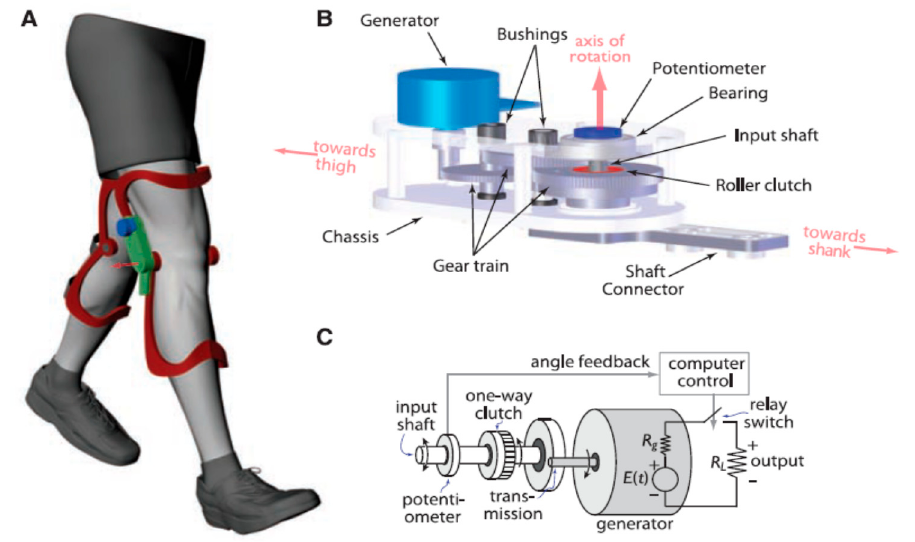
Figure 8. Knee wearable energy harvester with generative braking: ( A ) Conceptual drawing of the knee energy harvester; ( B ) its configuration of the knee energy harvester; and ( C ) schematic diagram of computer-controlled feedback system [47]. Reproduced with permission from the American Association for the Advancement of Science.